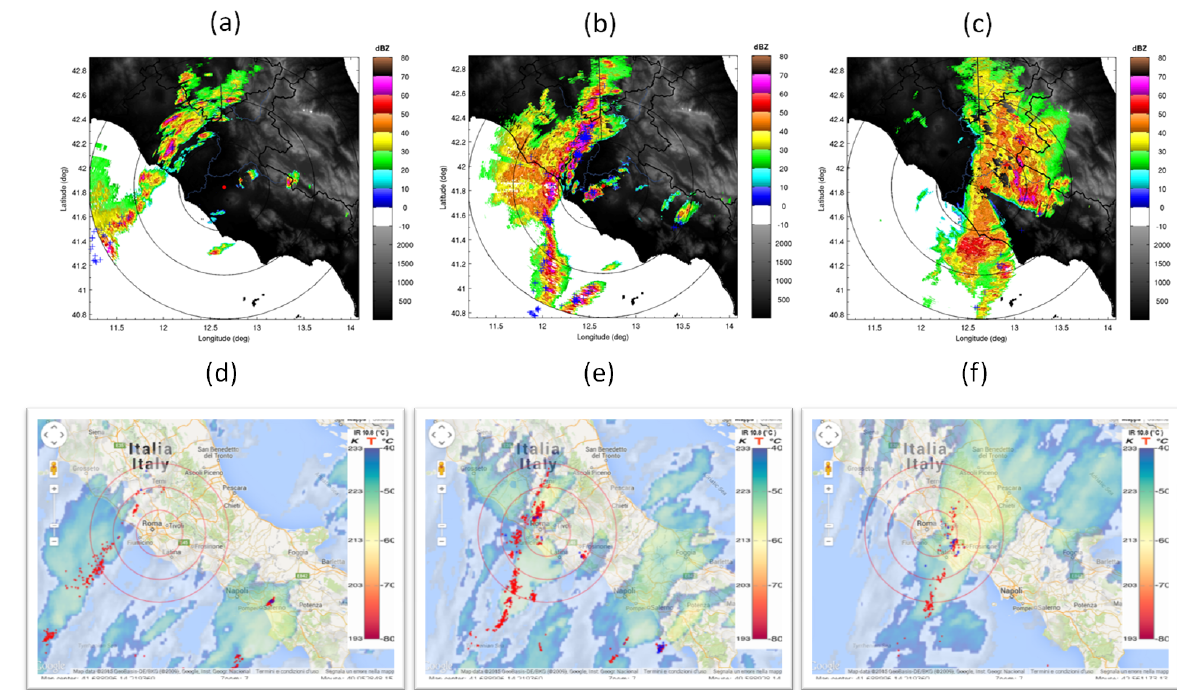
Figure 5. As in Fig. 3 for the 15 October 2012 at 16:00UTC (a, d) , 17:30UTC (b, e) , and 19:10UTC (c, f)